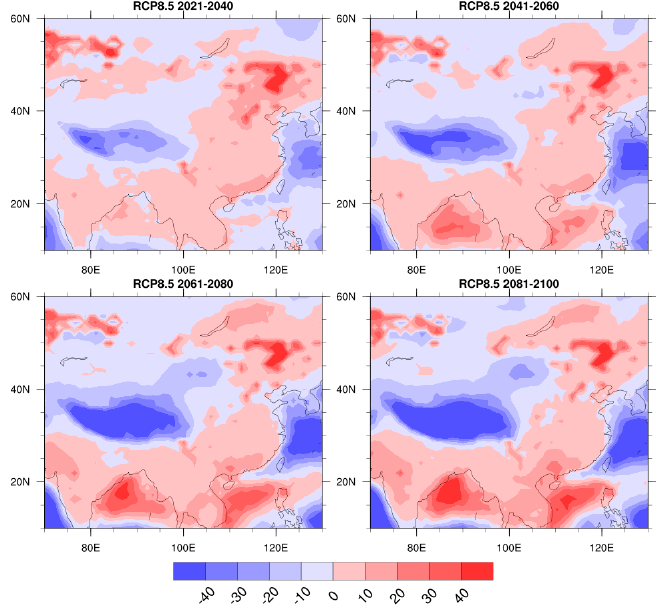
Figure 5. Projected multimidel meanchanges in mean WPD at 90 m hub-height in (W / m 2 ) for four future time slices relative to the period 1981–2005 under the RCP8.5 scenario.